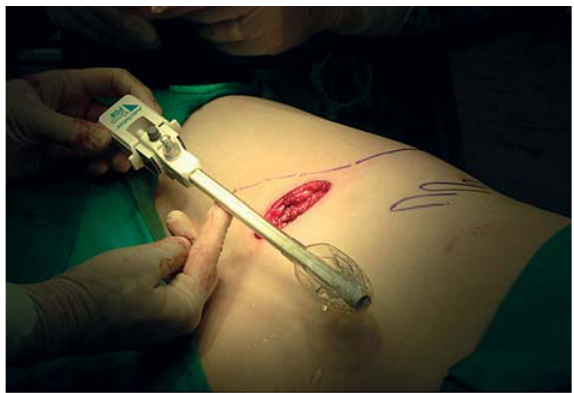
Figure 1 – An inflation balloon is inserted retroperitoneally via the 6 cm groin incision below the “bikini line”.